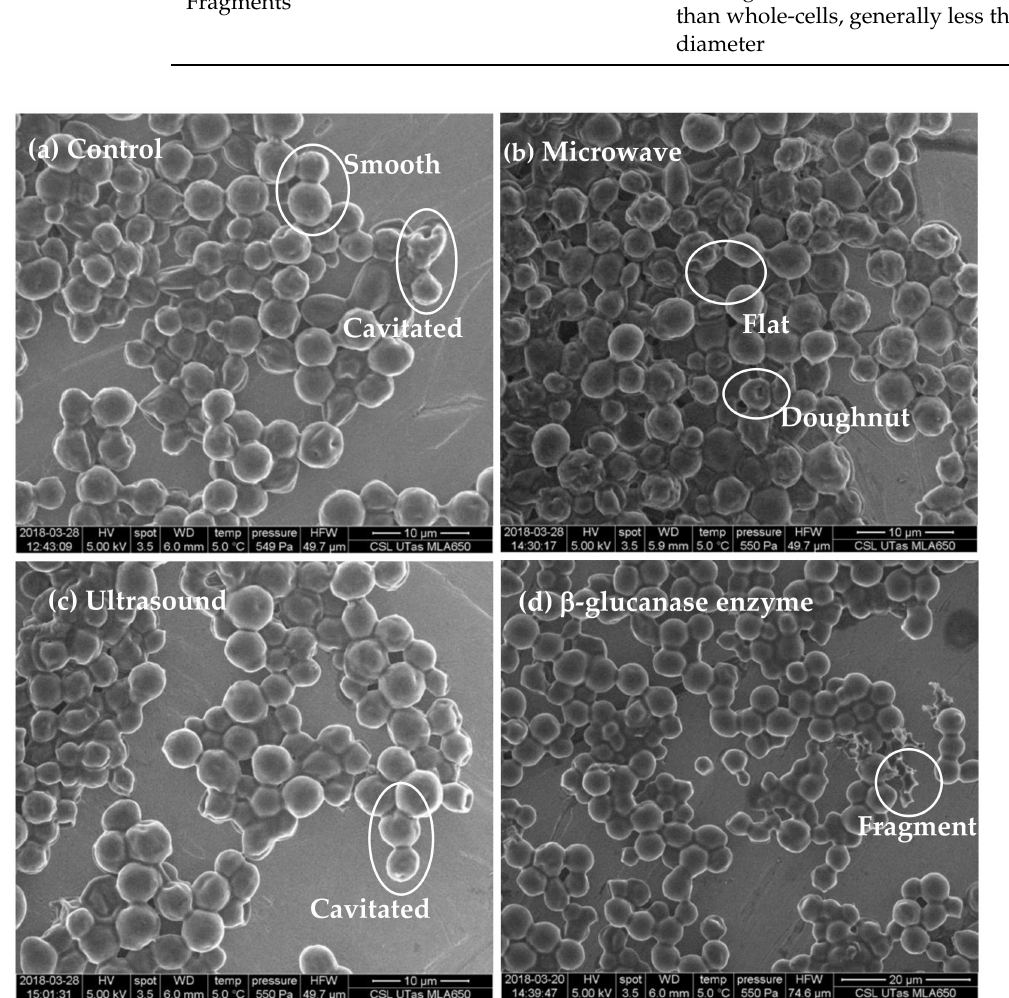
Figure 1. Scanning electron microscope images of S. cerevisiae whole-cells at tirage (time 0) exhibiting surface features of: ( a ) Control (untreated) cells exhibit ‘smooth’ external surfaces, budding, mother-daughter cells and ‘cavitated’ features on some cells; ( b ) Microwave treated cells displaying ‘flat’ and ‘doughnut’-shaped features; ( c ) Ultrasound treated cell surfaces displaying ‘cavitated’ features and ( d ) β -glucanase enzyme treated cells showing ‘cavitated’ features and